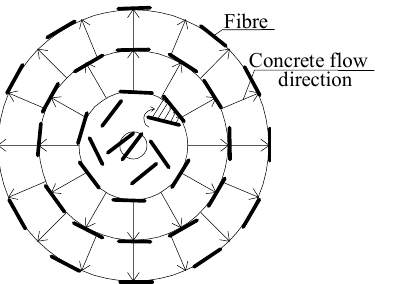
Figure 15: Explanation for fibre alignment in flowing concrete of a panel casting from the